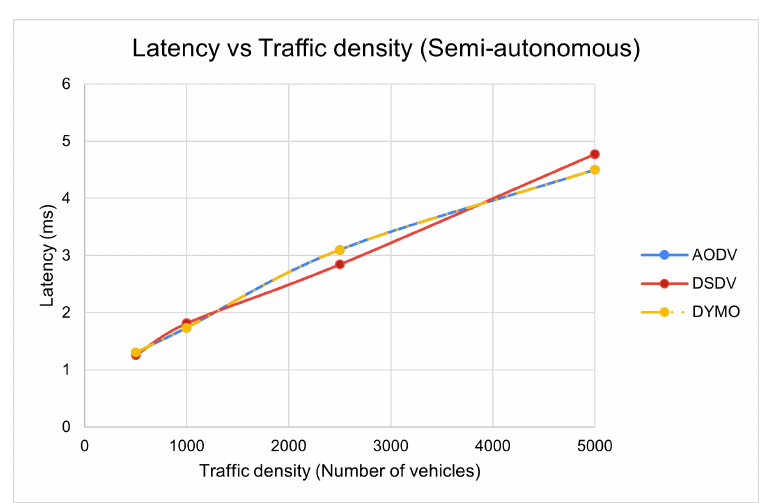
Figure 14. Latency graph for semi-autonomous vehicles with varying traffic